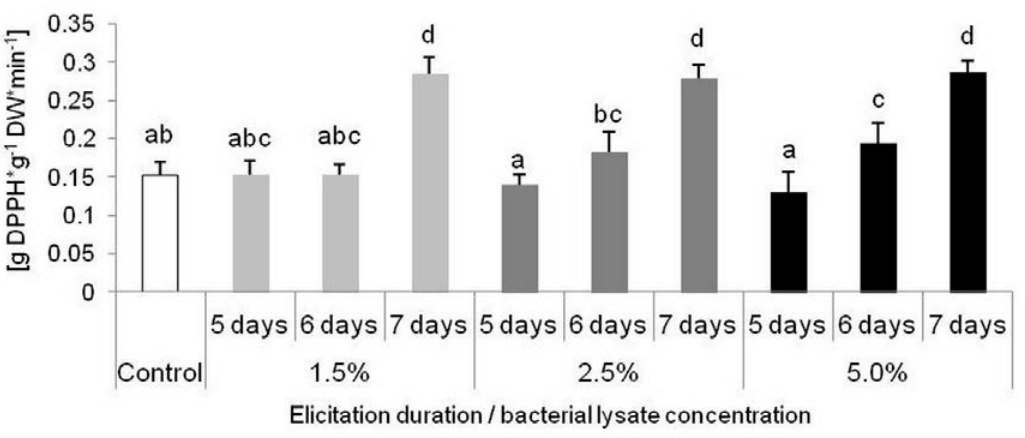
Figure 8. ROS scavenging activity (expressed as g DPPH reduced per g DW per minute) of Dionaea muscipula plants after 5, 6 and 7 days of elicitation with Cronobacter sakazaki lysate in different concentrations; different letters—significant difference between means at p < 0.05, bar—standard deviation.